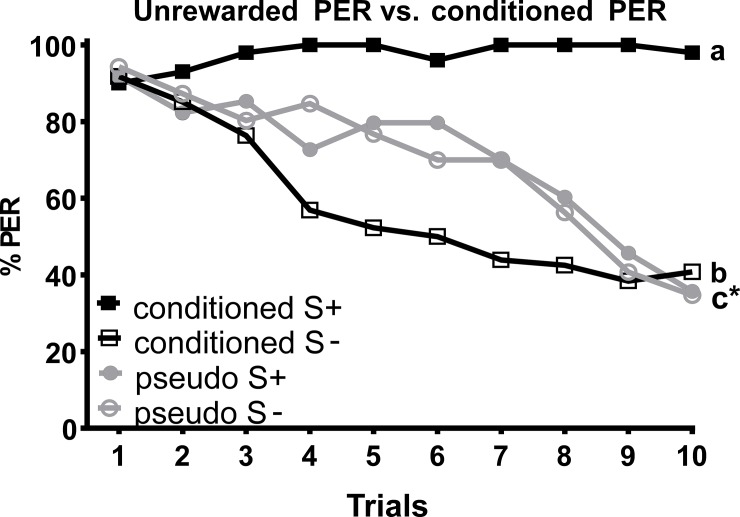
Percentage of proboscis extension responses (%PER) shown by Apis mellifera individuals in the unrewarded trials and differential chemotactile conditioning in the dark to the taste of apple versus almond pollen.Bees of the four groups were tested within the same experimental series. As before, the conditioned S+ and S- (N = 20) represent the rewarded and unrewarded conditioned stimulus. In contrast, both pseudo-S+ and S- represent unrewarded stimuli presented to a second group of individuals (N = 20). Both apple and almond pollen were used as (pseudo) S+ and S-. As there was no significant difference in PER rate between the taste of apple and almond pollen used as (pseudo) S+ or S- (z87 = 0.608, P = 0.543), both groups were summarized into one. Different letters next to the lines indicate significant differences between groups. An asterisk indicates the same letter for two overlaying curves.